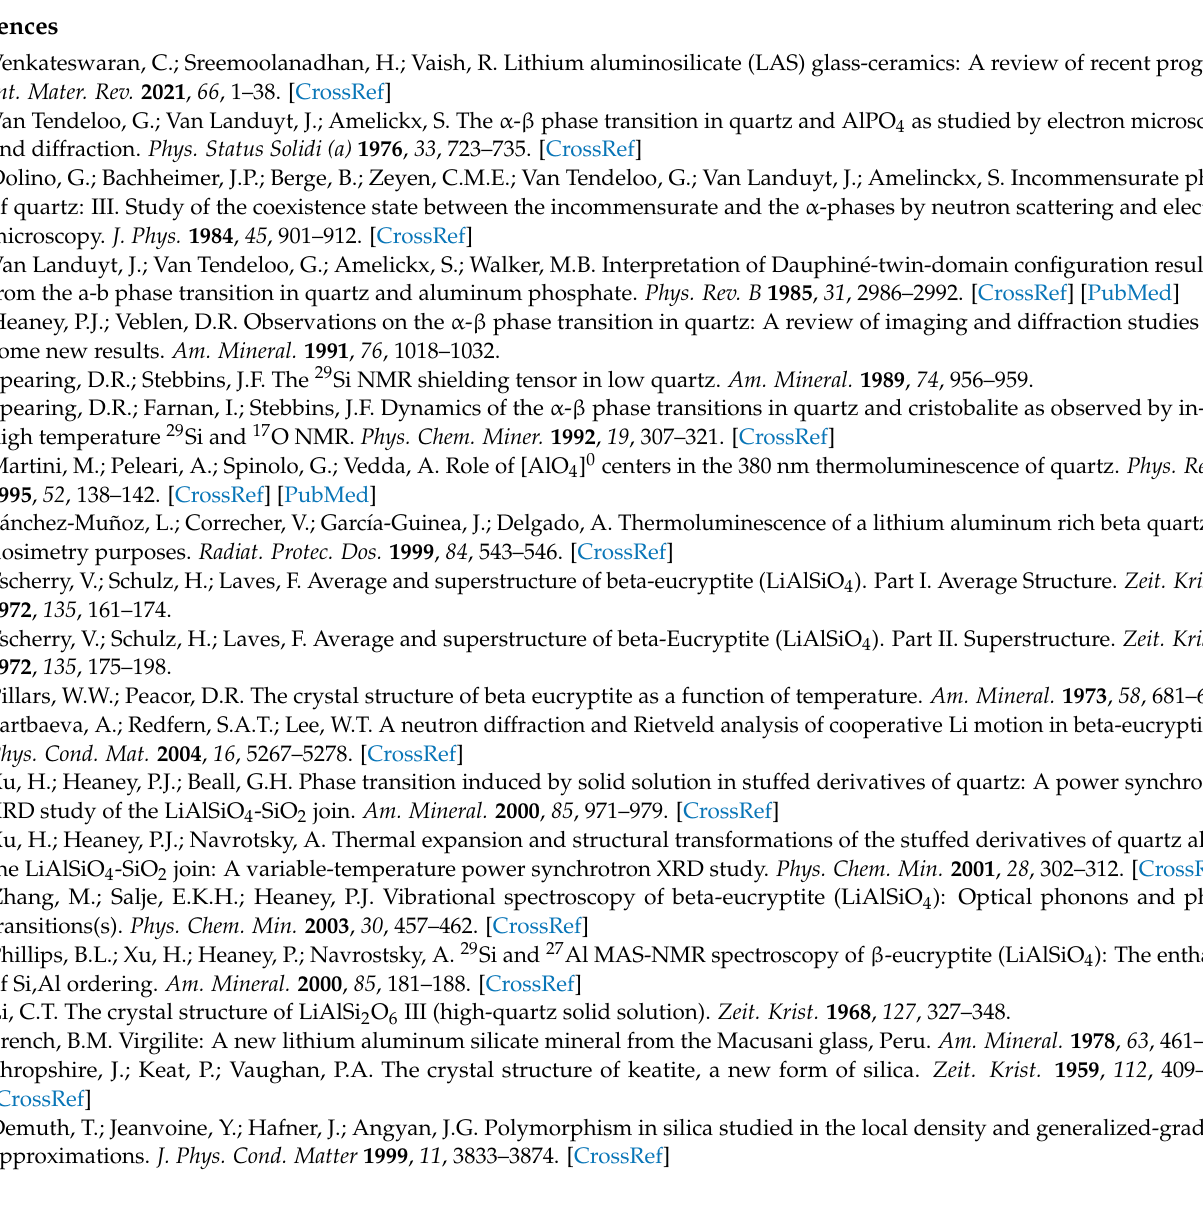
Figure A11. Example of a Rietveld refinement with three mineral phases, for sample x = 0.75 at 1200 ◦ C, experimental profile in blue, simulated profile in red, and difference in gray, with β -spodumene a = 7.4803 (8) Å and c = 8.995 (1) Å; α -quartz a = 5.0506 (1) Å; and c = 5.4397 (1)